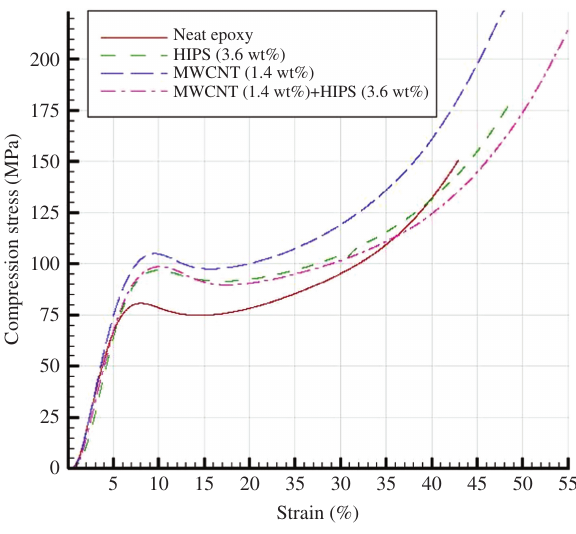
Figure 6 Stress-strain plot of the compression